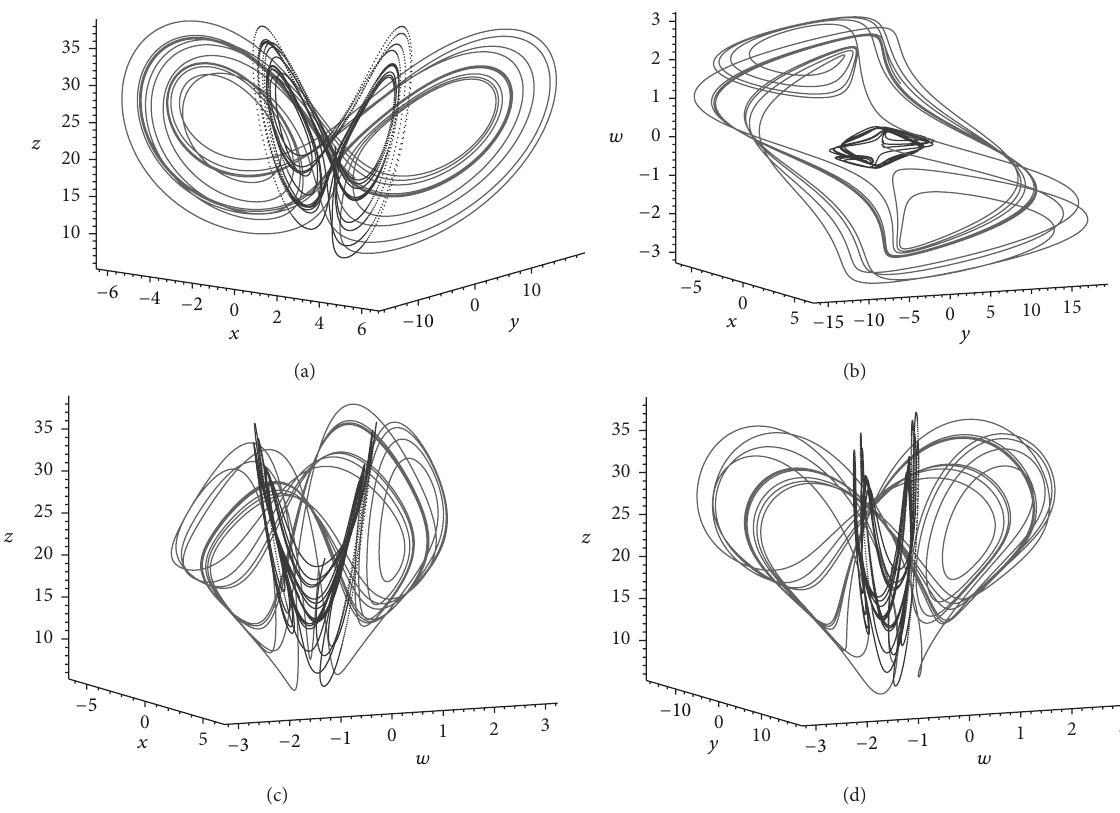
Figure 13: The function projection of the synchronized attractors in different spaces: (a) (𝑥,𝑦,𝑧) , (b) (𝑥,𝑦,𝑤) , (c) (𝑥,𝑤, 𝑧) , and (d) (𝑦,𝑤, 𝑧) . The solid line denotes the drive system; the dashed line denotes respond system